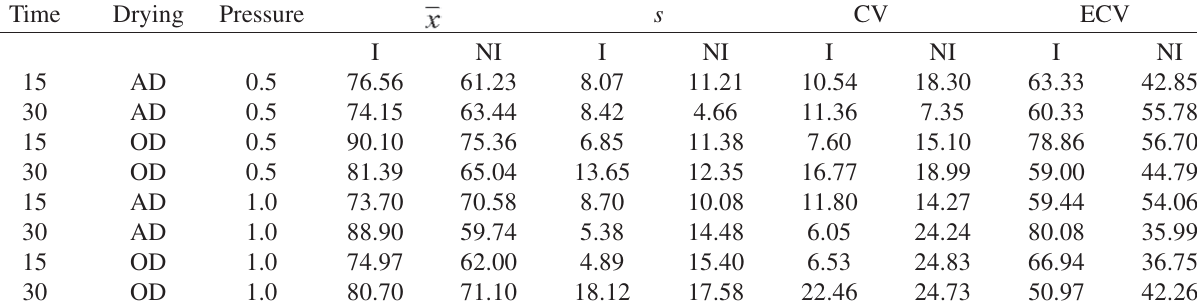
Table 2. Values of the impregnated and nonimpregnated Eucalyptus grandis.